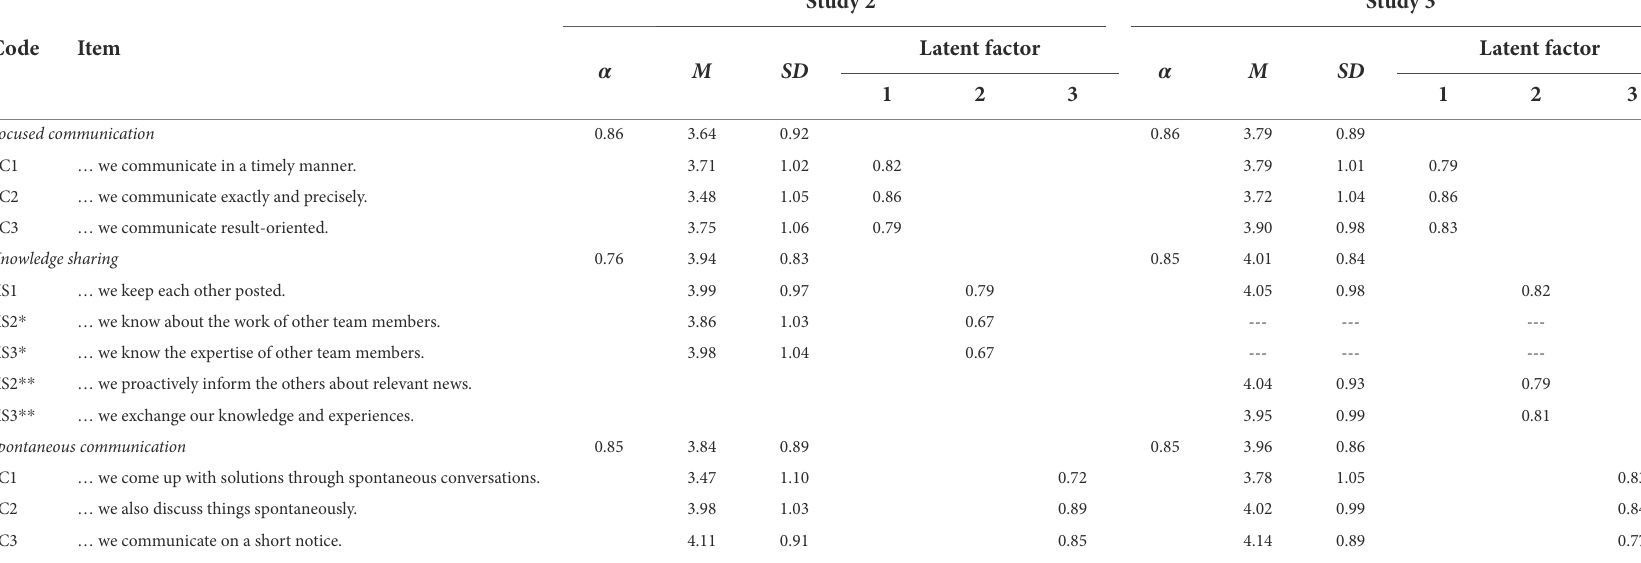
TABLE 2 Study 2 and 3: Item wording, descriptive statistics, Cronbach’s alphas and standardized factor loadings from confirmatory factor analysis (individual level).